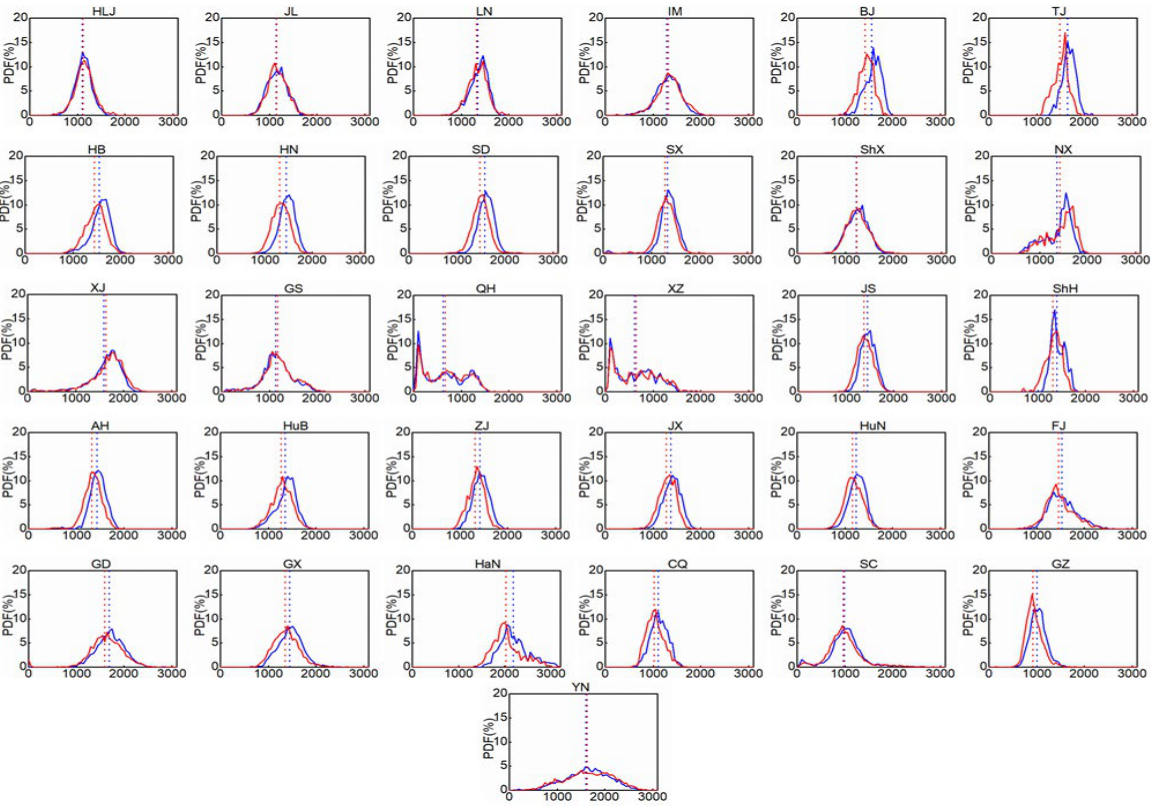
Figure 6. Probability density function patterns of insolation during the potential agricultural growing season in 1961–1990 and 1991–2020 (blue and red curve represents the PDF value in 1961–1990 and 1991–2020, respectively; blue dotted line and red dotted line represents the mean magnitude of insolation in 1991–2020).